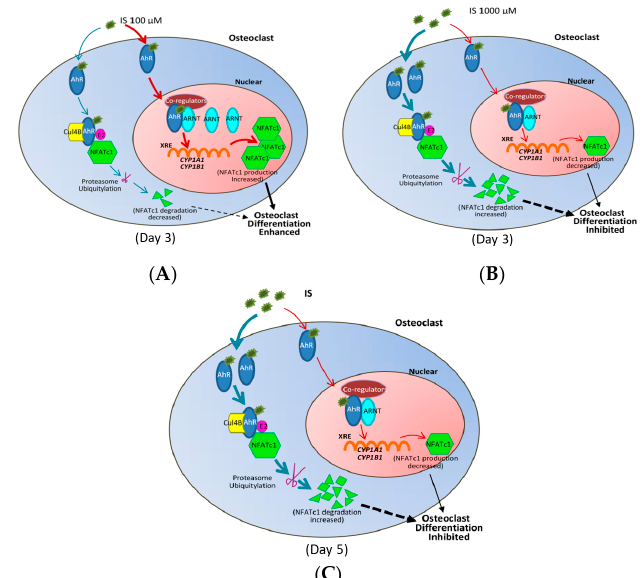
Figure 6. ARNT is an important modulator of AhR’s dual functions under IS treatment. ( A ) ARNT switches AhR from a ligand-activated transcription factor to an E3 ubiquitin ligase under IS treatment on Day 3. At 100 µM IS, ARNT is available and AhR functions as a ligand-activated transcription factor, increasing CYP1A1 and CYP1B1 expression to promote NFATc1 expression, thereby increasing osteoclast precursor differentiation. The red pathway represents the production of NFATc1, and the blue represents the degradation of NFATc1. ( B ) On Day 3 at 1000 µM IS, ARNT is inaccessible and AhR functions as an E3 ubiquitin ligase, leading to the proteasomic degradation of NFATc1, thereby inhibiting osteoclast precursor differentiation. The red pathway represents the production of NFATc1, and the blue pathway represents the degradation of NFATc1. ( C ) ARNT controls AhR to act as an E3 ubiquitin ligase under IS treatment on Day 5. As ARNT expression is inhibited, the transcriptional activity of AhR is blocked, while its E3 ubiquitin ligase function is enhanced, thereby increasing NFATc1 ubiquitination and inhibiting osteoclast differentiation. The red pathway represents the production of NFATc1, and the blue, the degradation of NFATc1.